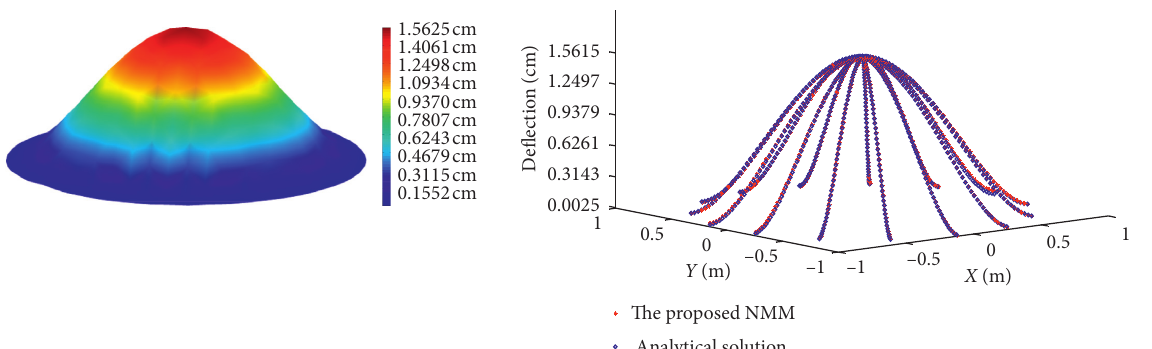
Figure 11: Deflection of a clamped circular plate under a distributed load calculated with the proposed NMM with 0.15 × 0.15 mesh and the analytical method.